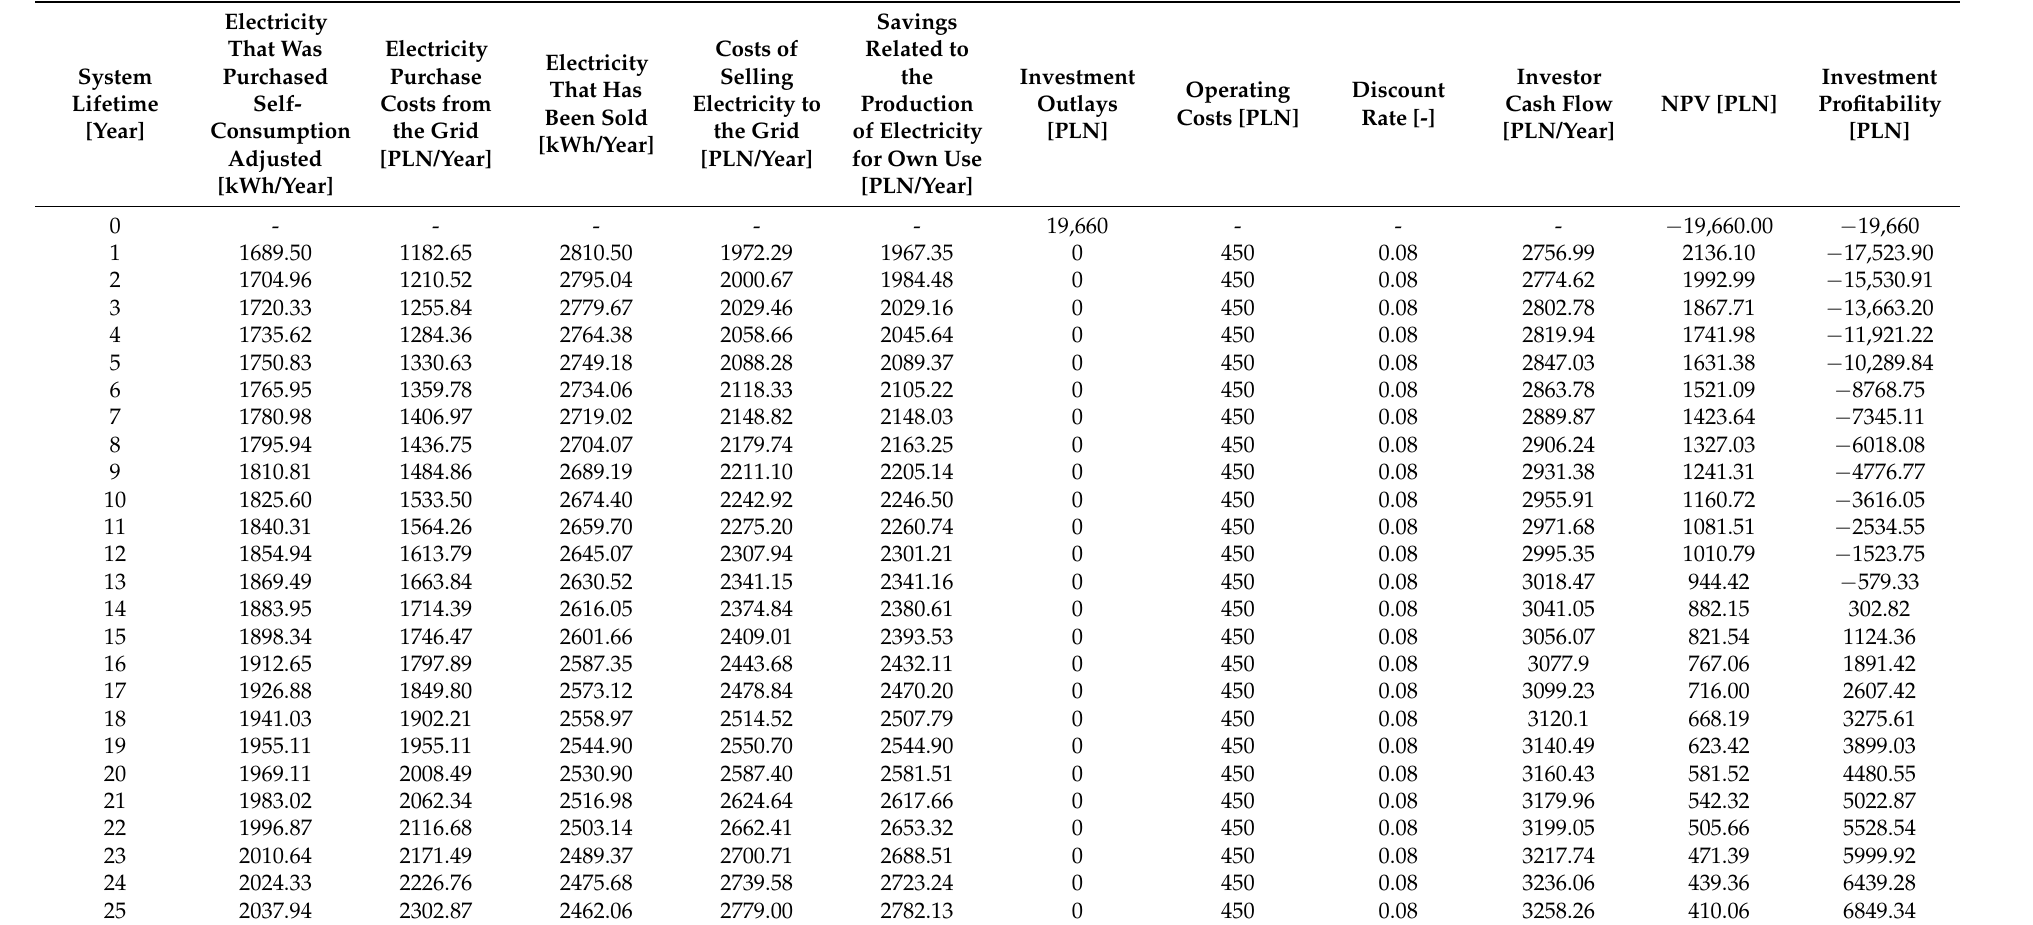
Table A5. NPV results of the PV installation for the net-billing system based on monthly prices, at a 50% self-consumption